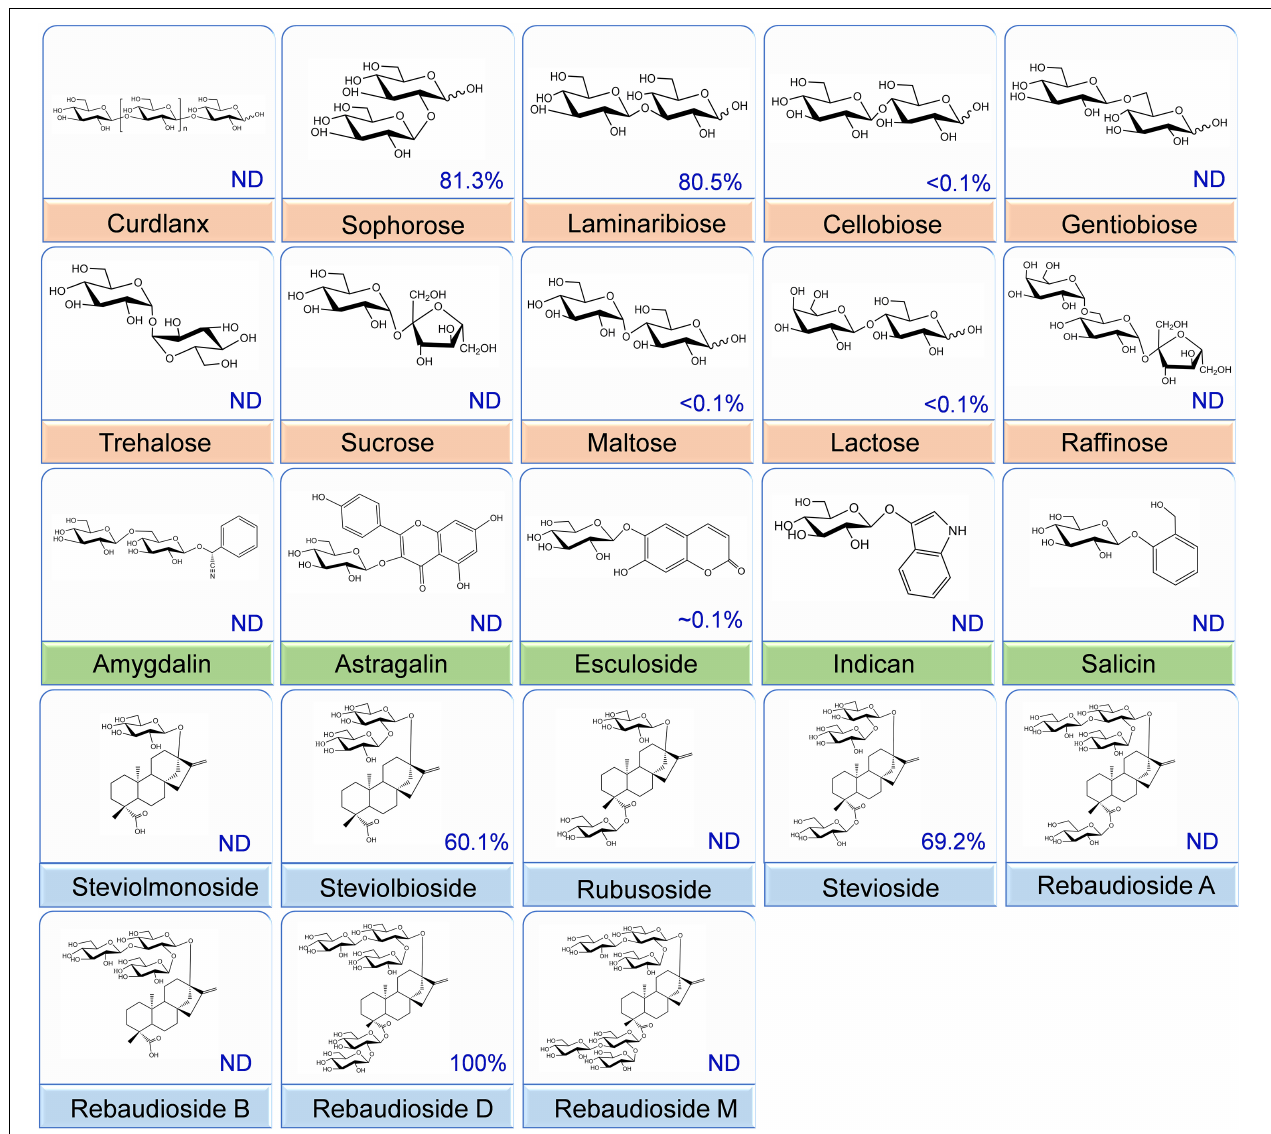
FIGURE 3 | Substrate specificity of the Cs BGL. Reactions were performed by incubating the Cs BGL (0.5 U/ml) with 5 mM various substrates at 45 ◦ C for 5 min. The relative activity (%) with different substrates is given. “ND” indicates that no activity was